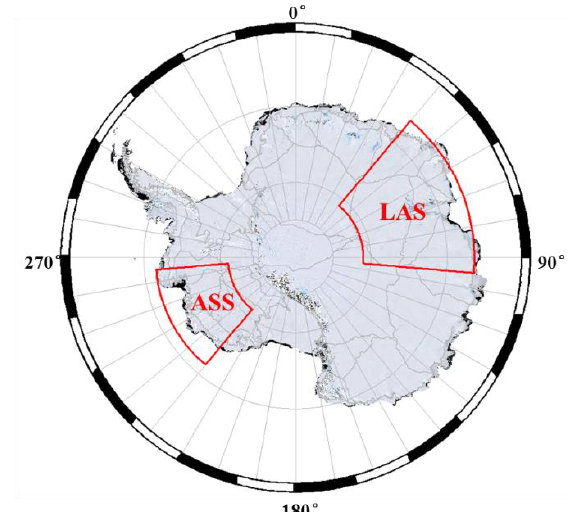
Figure 1.Antarctic ice sheet and its sub-regions, the LAS and